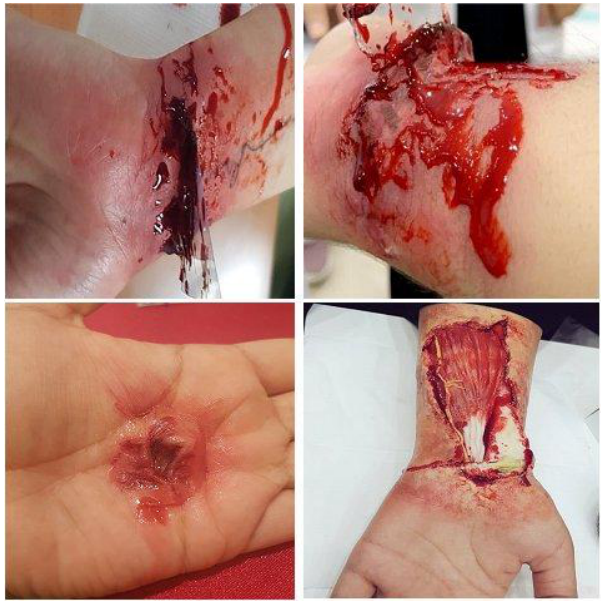
Figure 1: Photographs showing different types of moulage on standardized